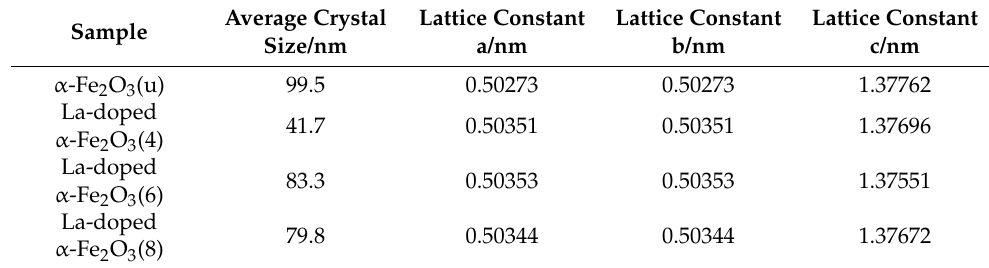
Table 2. Average crystal size and lattice constant of